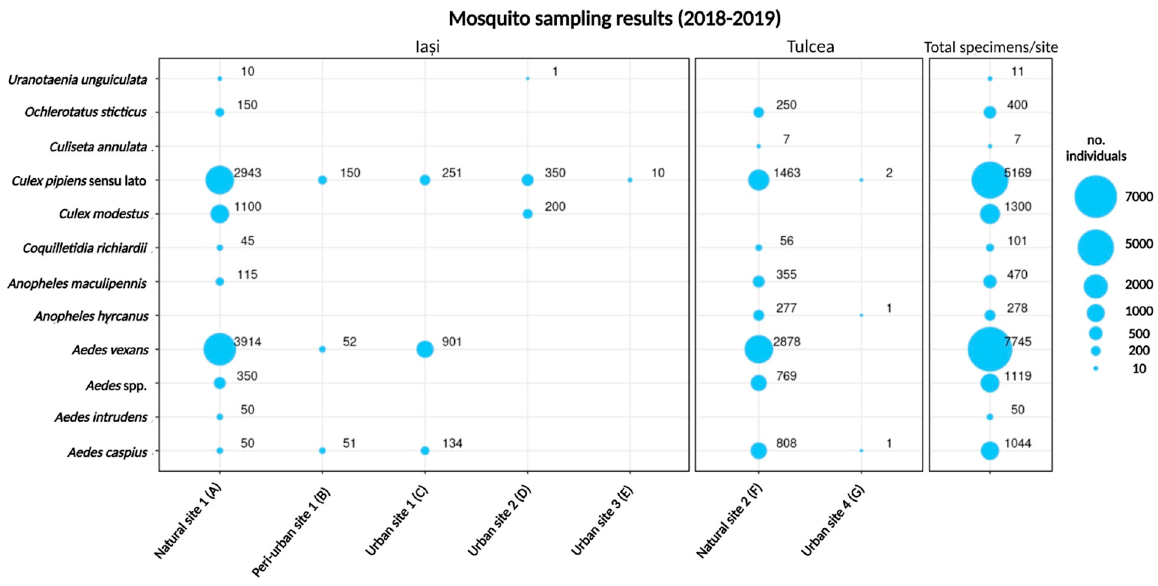
Figure 2. Number of mosquito specimens trapped in 2018 and 2019 in eastern Romania, ordered by taxa and sampling site (Ia ș i county in the left panel, Tulcea in the central panel, and total per taxa on the right panel).